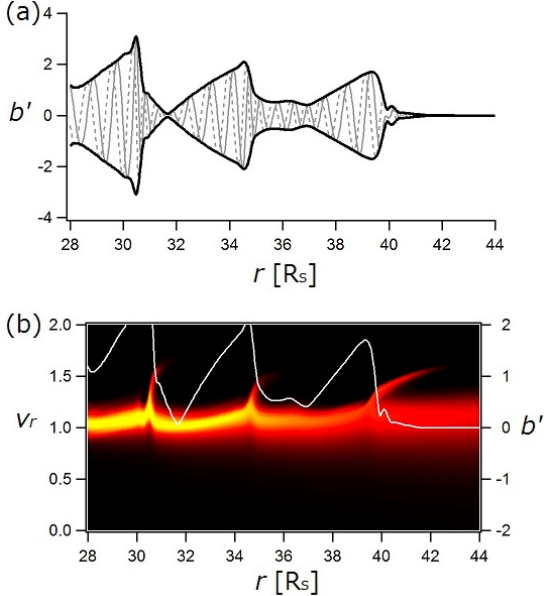
Fig. 5. The snapshot of (a) the transverse magnetic field and (b) g 0 at t = 22 . 0 in Run A.